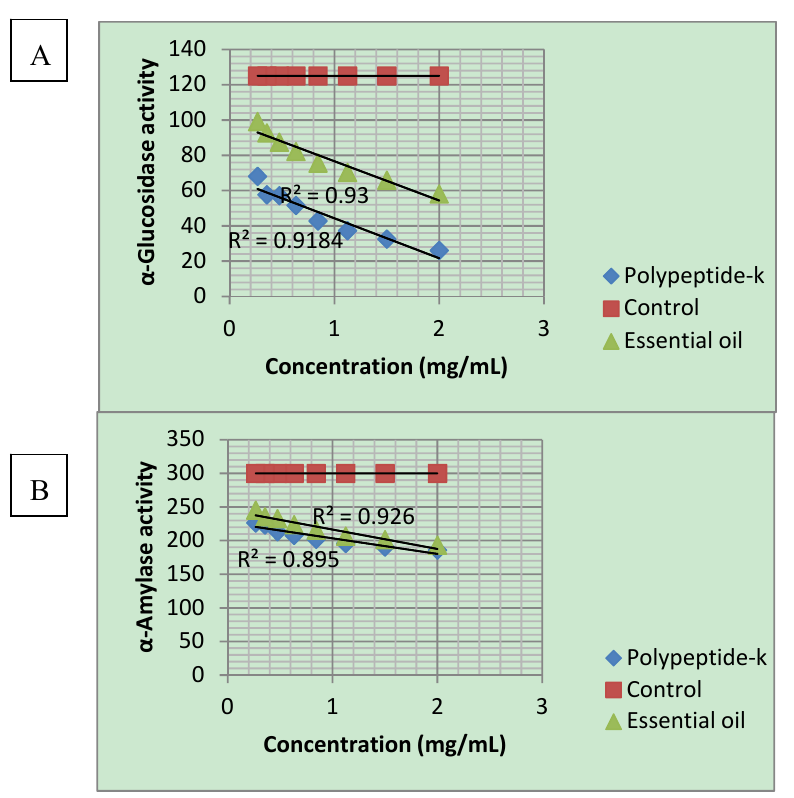
Figure 1. Dose-dependent inhibition of α -glucosidase and α -amylase activities by polypeptide-k and Momordica charantia seed oil. A: α -glucosidase; B: α